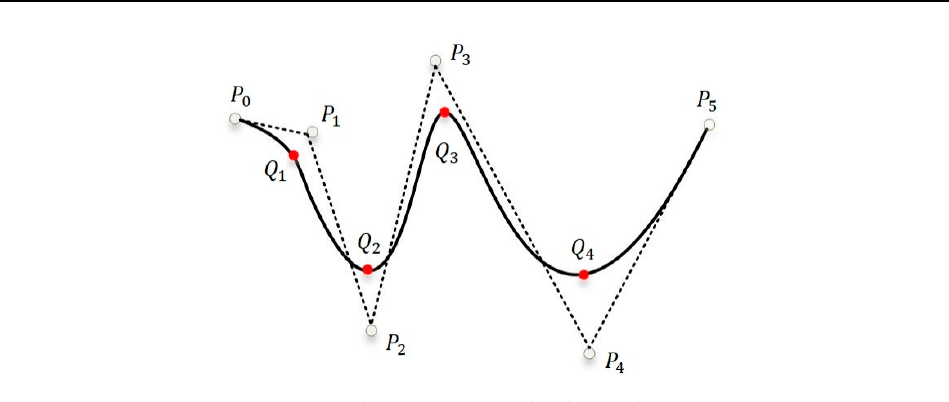
Figure 2. B-spline curve control polygon diagram.